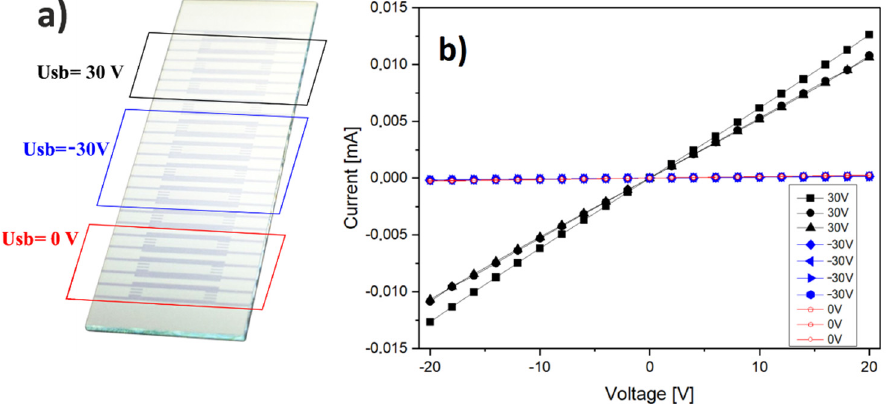
Figure 6. Electrically modified polymer deposition in the solution-coated pristine RP3HT film is accompanied by changed charge transport properties. ( a ) A scale-up substrate with 12 sets of ITO finger electrodes. The color frames mark film regions with different voltages Usb applied during H-dip coating. ( b ) Current–voltage characteristics of the electric circuits for the RP3HT film sections formed at different voltages Usb . Note that Usb = 30 V induces both a higher conductance and increased RP3HT deposition ( ∆ m > 0 in Figure